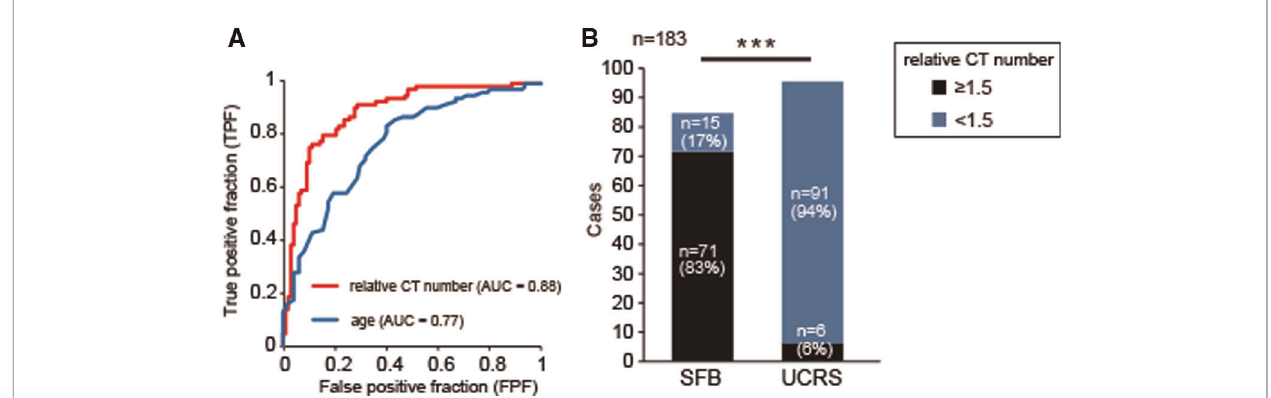
FIGURE 3 | Receiver operator characteristics (ROC) curve analysis for relative CT number and age, ( A ) ROC curves for application of the classi fi cation modeling to the dataset. The curve was created by plotting the true positive fraction (TPF, y-axis; the sensitivity) against the false positive fraction (FPF, x-axis; the speci fi city) at various threshold settings. Thered line indicates the ROC curve for relative CT number, and the blue line indicates the curve for age. The area under the ROC curve for relative CT number was signi fi cantly greater than that for age (age vs. relative CT number, 95% CI, 0.03 – 0.21; χ -square test, p =0.008). ( B ) Comparison of relative CT numbers between SFB and UCRS. A relative CT number greater than orequal to 1.5 was signi fi cantly associated with the detection of SFB. Chi-square test, n =183, *** p